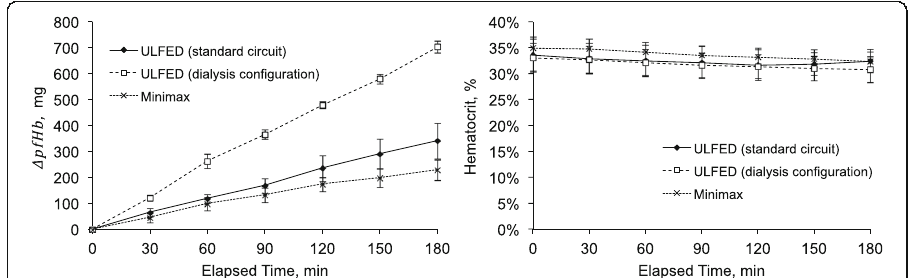
Fig. 5 Average change in total plasma free hemoglobin (pfHb) versus baseline (left) and average hematocrit (right) at 30 min sampling intervals during in vitro hemolysis tests. Error bars represent one standard deviation at each time-point between tests for each circuit